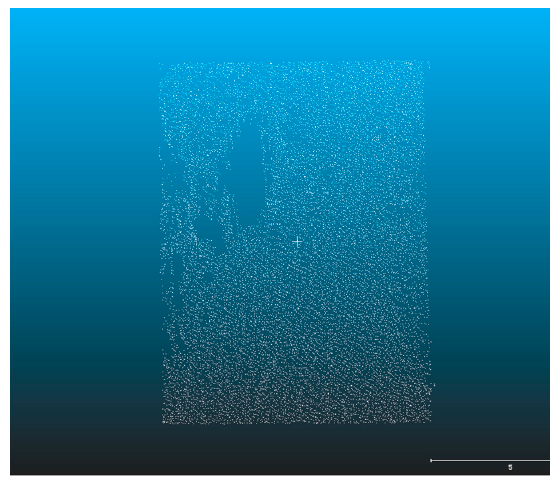
Figure 21. UAV Nadir in Photoscan.